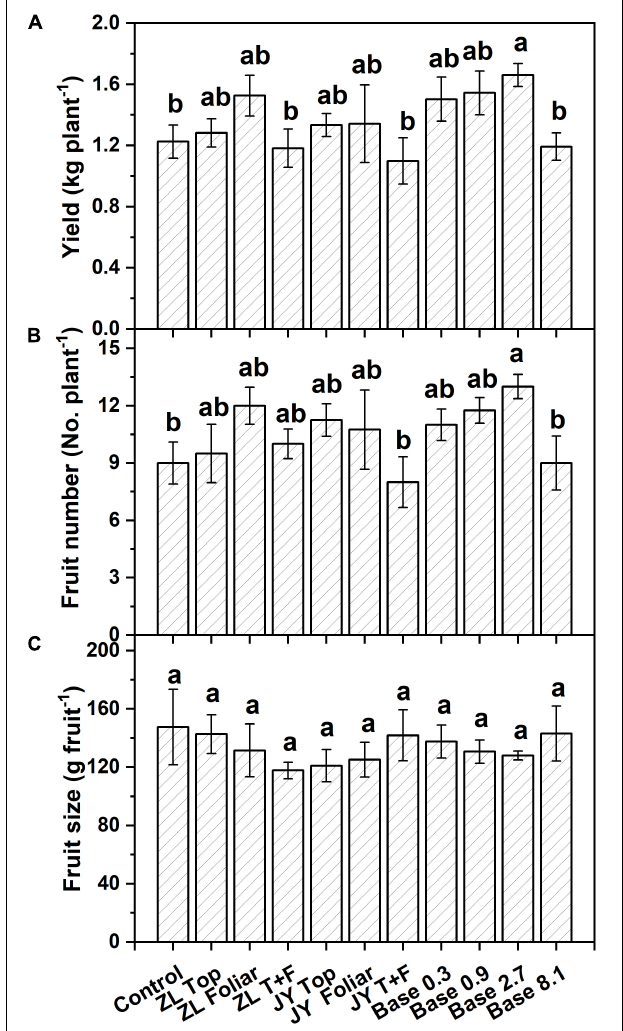
FIGURE 1 | The effect of fulvic acids on total yield (A) , fruit number (B) , and fruit size (C) of tomato plants cv. Hezuo906 grown in soil culture for 126 days from transplanting at the final harvest. Data are means ± s.e ( N = 5). The same letters denote insignificant differences ( P < 0.05) among treatments according to Duncan’s new multiple range test (Experiment